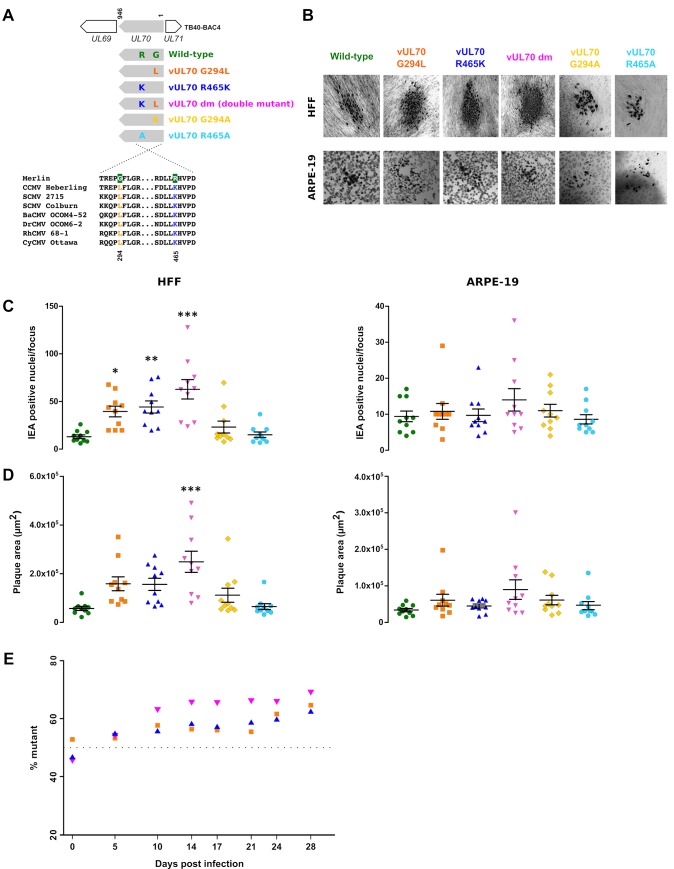
Phenotypic effect of positively selected sites.(A) Generation of vUL70 mutant strains. The HCMV UL70 gene region is schematically represented together with the induced amino acid replacements at positively selected sites (G294 and R465). The alignment of a few catarrhini-infecting CMVs are shown. Wild-type and mutant viral strains are color-coded. (B) Representative light microscopy images of infectious foci are shown as seen in HFFs or ARPE-19 cells (5 days post infection). Original magnification: 20X. (C) IEA positive nuclei/focus. Each data point of the graph represents the number of IEA-positive nuclei of one focus at day 5 post infection. Bold horizontal lines depict the median number of IE antigen-positive cells/focus for each virus. One-way ANOVA followed by Tukey's post-hoc test was used for comparison of mutant viruses versus the wild-type (*P < 0.05; **P < 0.01; ***, P<0.001). (D) Plaque areas were calculated using ImageJ software. Horizontal lines represent mean values ± standard deviations. One-way ANOVA followed by Tukey's post-hoc test was used for comparison of mutant viruses versus the wild-type (***, P<0.001). (E) Head-to-head competition assays of three mutant viruses against the wild-type. HFFs were infected with a 1:1 ratio of wild-type and each mutant virus (MOI: 0.0005 PFU/ml). At different time points, total genomic DNA was extracted and subjected to deep sequencing. The relative proportion of mutant viral DNA is plotted. Each point represents the mean of two replicates.